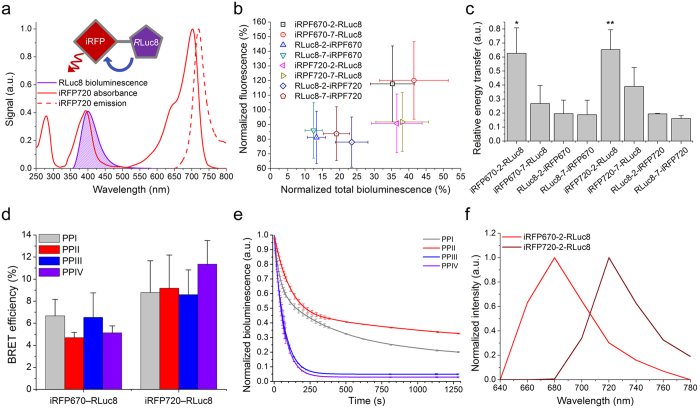
Engineering and characterization of two-color near-infrared luciferases.(a) Schematic of the domain structure of chimeric luciferase and bioluminescence resonance energy transfer between RLuc8 and iRFP720. (b) NIR fluorescence signal of live HeLa cells transiently transfected with the NIR chimeric luciferase constructs, detected by flow cytometry and normalized to brightness of the respective iRFP protein and plotted against total bioluminescence of HeLa cells lysates with PPII substrate normalized to brightness of RLuc8. (c) Relative BRET between RLuc8 and FPs for each construct obtained by dividing NIR bioluminescence signal at the optimal wavelength by total bioluminescence signal obtained with PPII substrate. (d) BRET efficiency for iRFP670—RLuc8 and iRFP720—RLuc8 measured with different substrates. (e) Bioluminescence reaction kinetics of different substrates catalyzed by iRFP720—RLuc8 at 25 °C in vitro. (f) Bioluminescence spectra of iRFP670—RLuc8 and iRFP720—RLuc8 measured using 20 nm bandpass filters. Error bars, s.d. (n = 3). *P < 0.05 (t-test) versus iRFP670-7-RLuc8, RLuc8-2-iRFP670 and RLuc8-7-iRFP670. **P < 0.05 (t-test) versus iRFP720-7-RLuc8, RLuc8-2-iRFP720 and RLuc8-7-iRFP720.